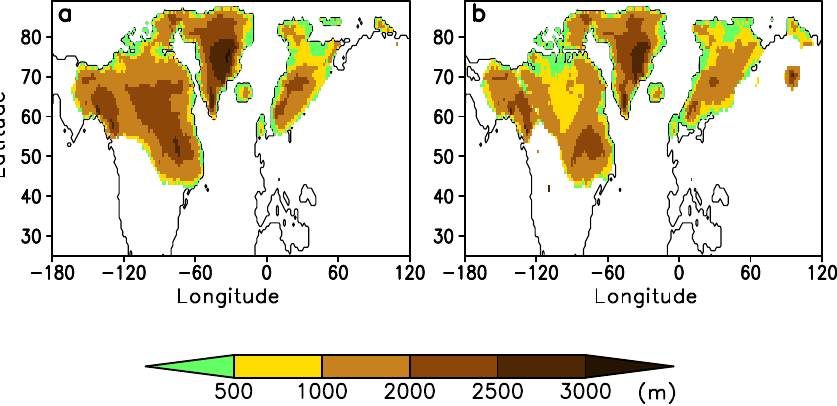
Fig. 8. Thickness of the simulated ice sheets when the maximum area of the entire simulation was achieved in experiment CC200 (a) and REG200 (b) ,